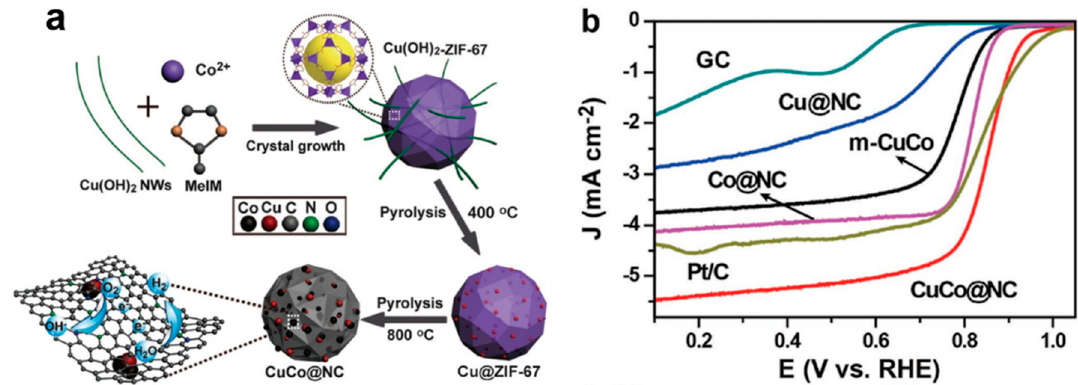
Figure 10. ( a ) The chemical synthesis route of Co–N@HCS catalyst; ( b ) ORR current-potential characteristics on (Cu and Co) embedded N-doped carbon materials in O 2 -saturated 0.1 M KOH solution at a scan rate of 10 mV s − 1 and rotation speed of 1600 rpm (cathodic sweep) at room temperature (25 ± 1 ◦ C). The catalyst loadings of all samples were 0.182 mg cm − 2 . Reproduced